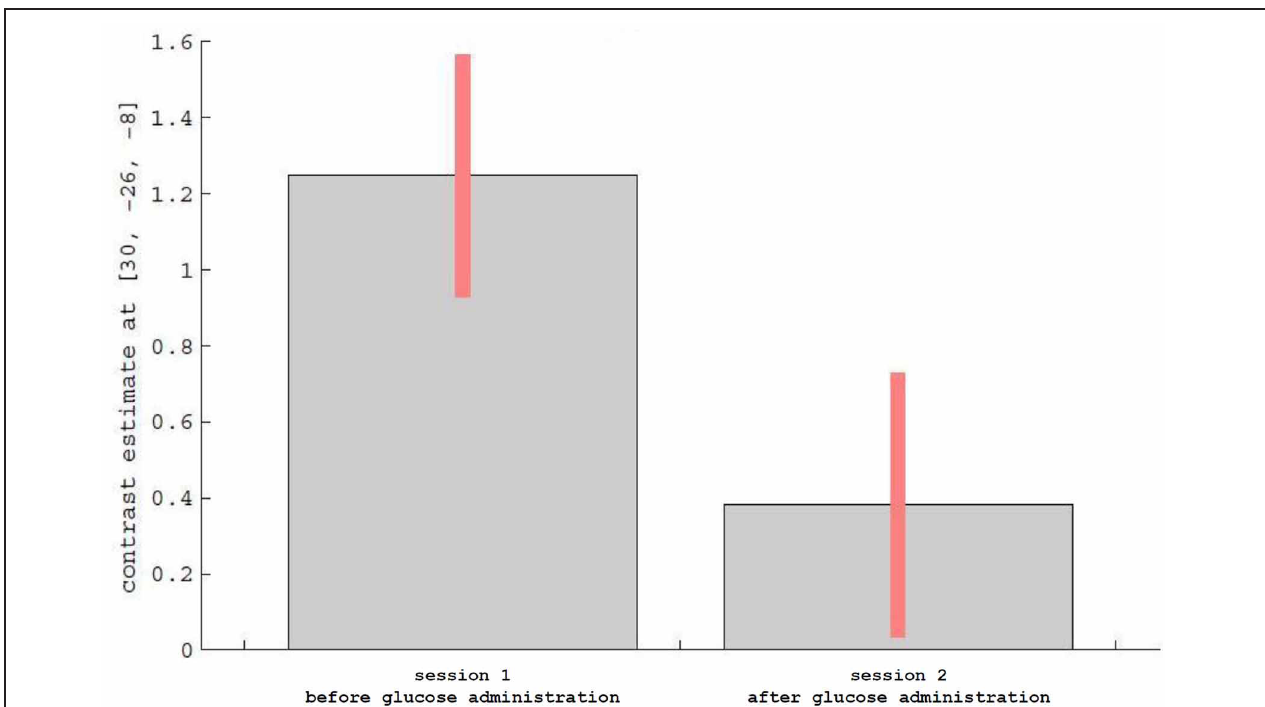
FIGURE 4 | Description of contrast estimates for the results of the main effect runs in the hippocampus, as shown in Figure 3.